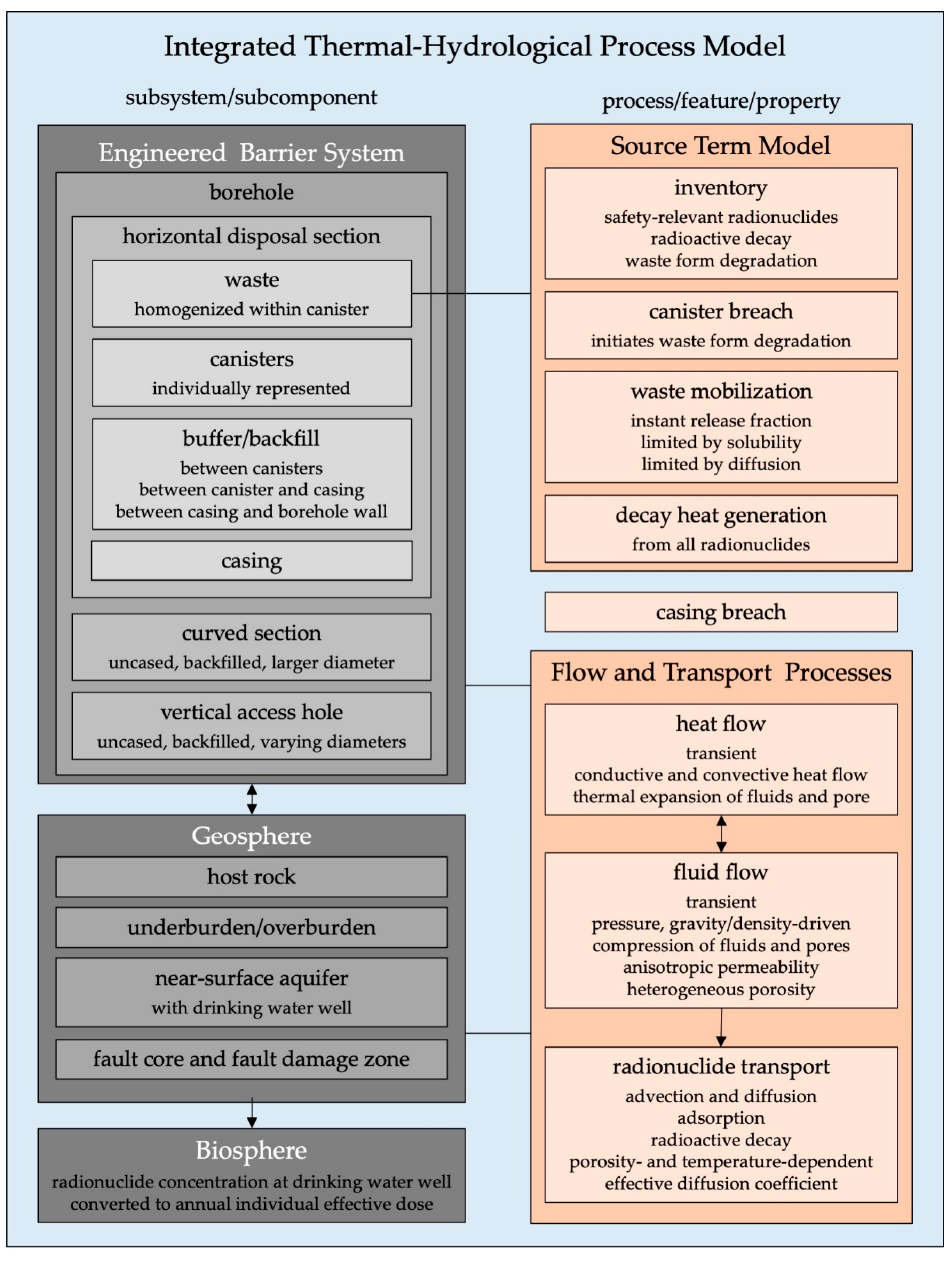
Figure 2. System components and processes represented in an integrated thermal–hydrological model of deep horizontal borehole repository.